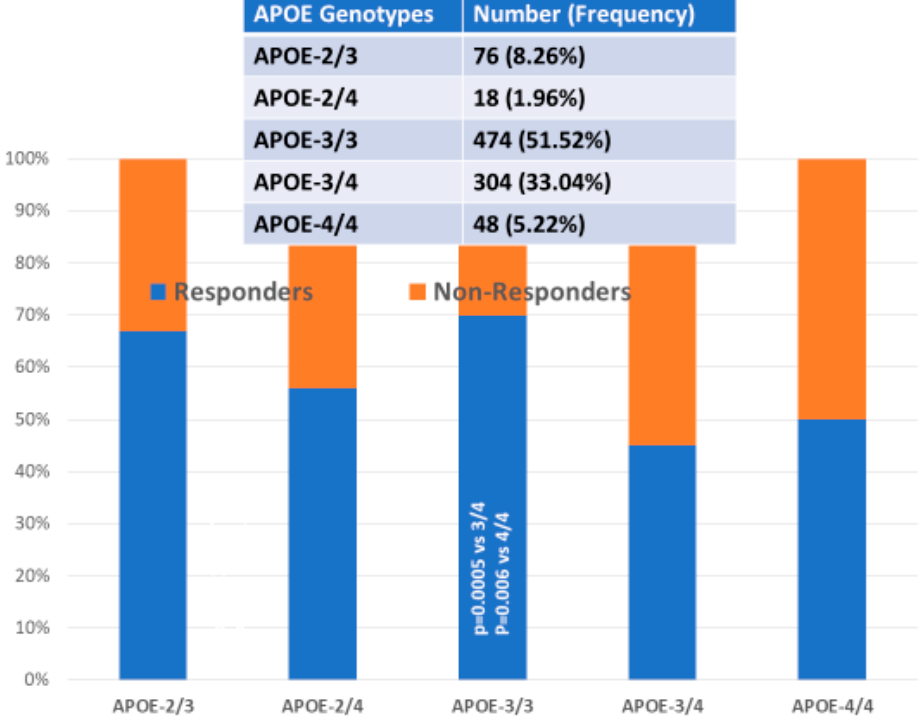
Figure 4. APOE-related responder / nonresponder rate in patients with Alzhimer’s disease treated with a multifactorial / combination treatment for one year. Responders: Final Mini-Mental State Examination (MMSE) score > basal MMSE score. NonResponders: Final MMSE score < basal MMSE score.